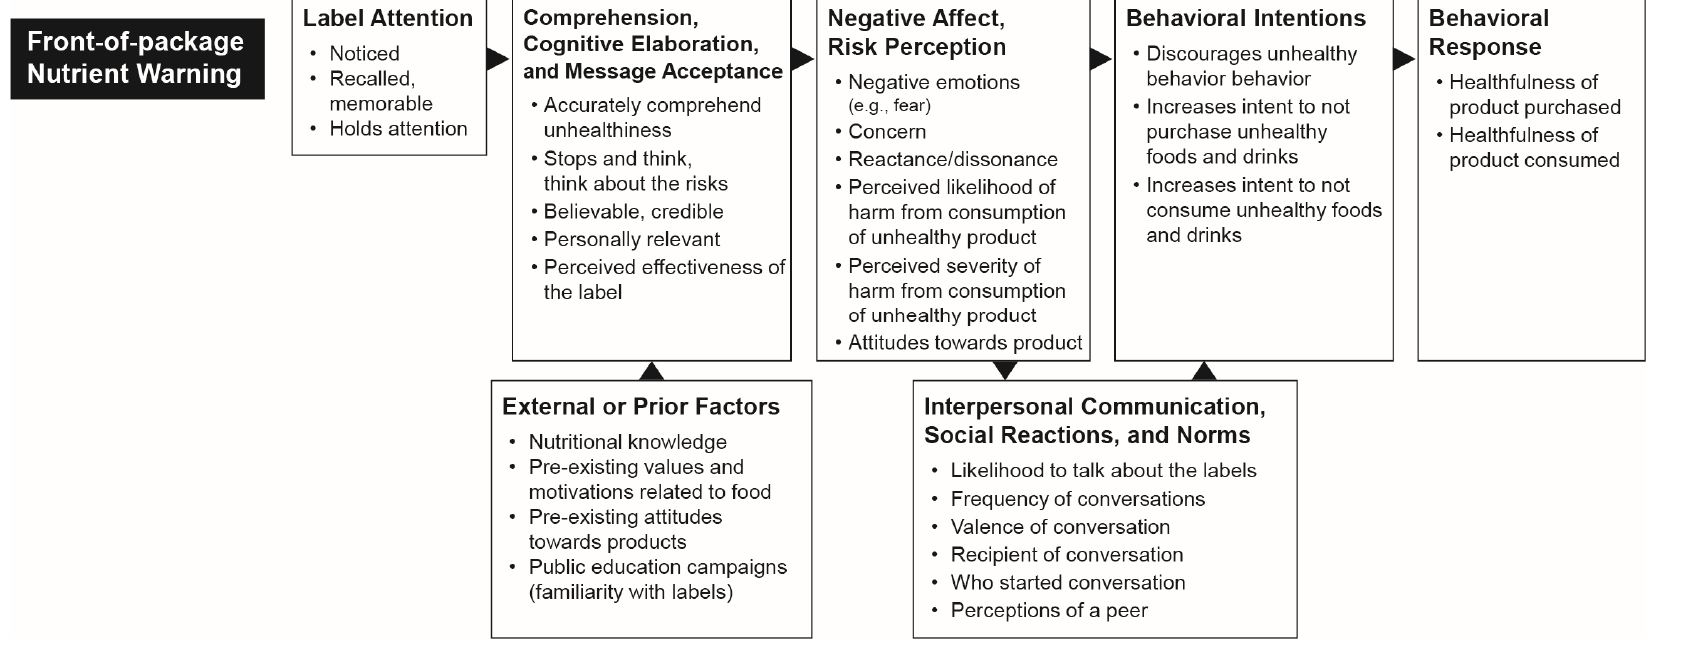
Figure 1. Conceptual model.